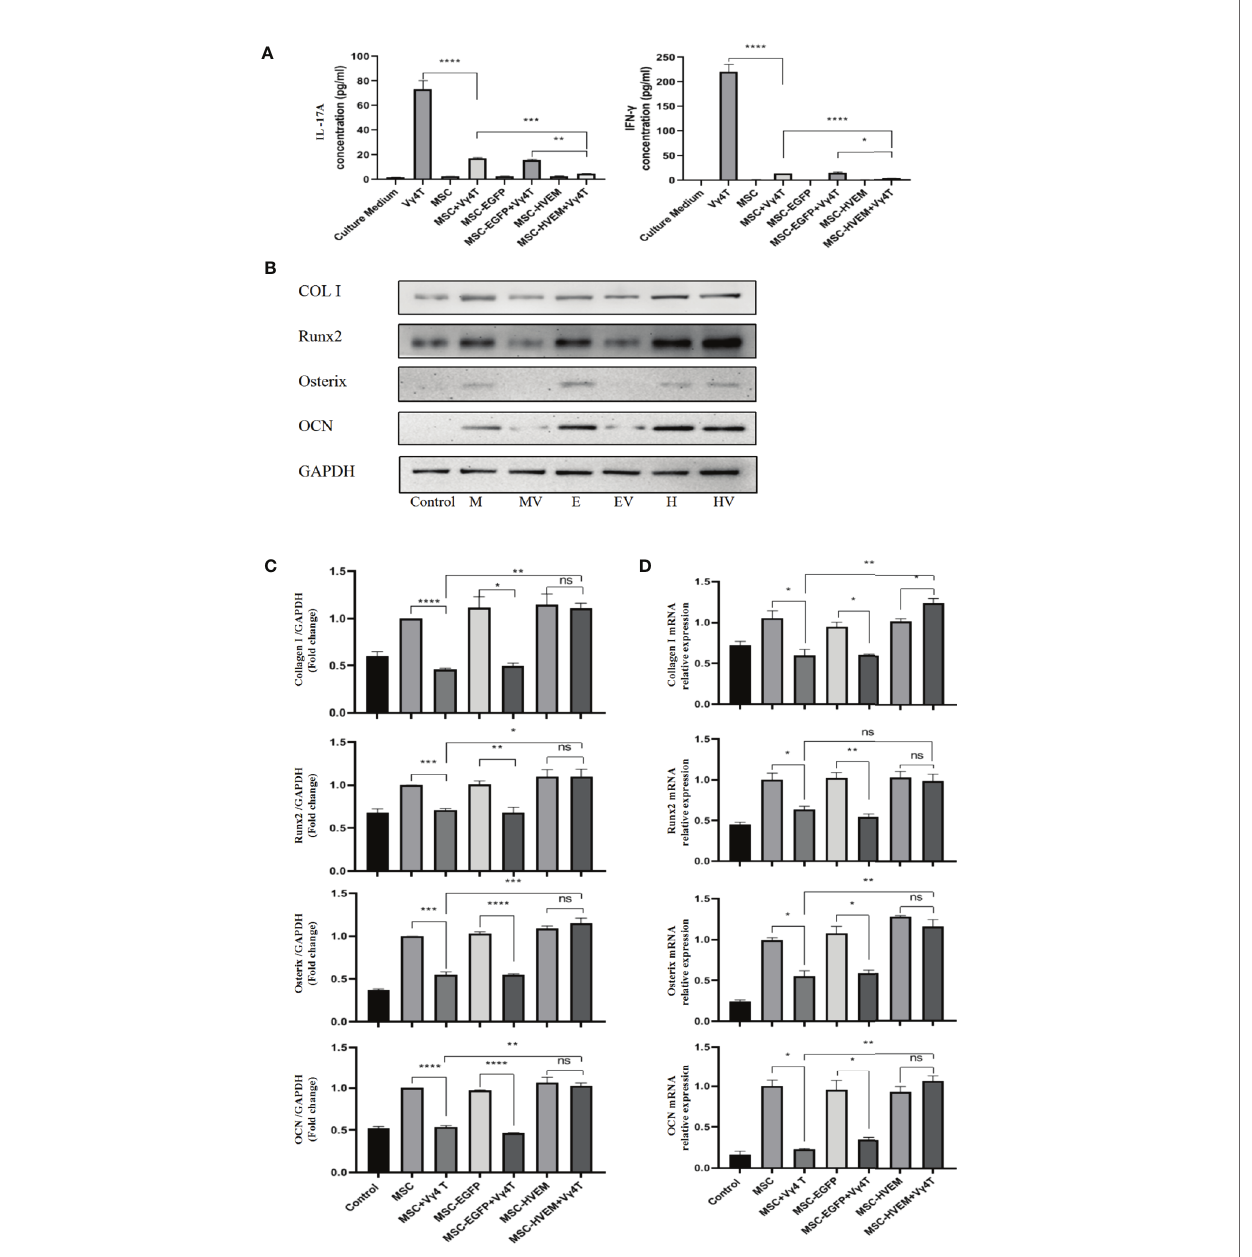
FIGURE 4 | V g 4T cells co-culture with MSCs or MSCs-HVEM then induced in osteogenic medium. (A) MSC can inhibit IL-17A and IFN- g secretion from puri fi ed V g 4T cells cells, the inhibition ability of MSCs-HVEM was stronger than that of MSC cells. (B, C) The Expression of markers of osteogenesis such as COL I, Runx2, Osterix, and OCN by MSCs or MSCs-HVEM with or not with V g 4T cells(the ratio is 1:4) were measured by Western blotting analyses, the osteogenic differentiation ability of MSC decreased when co-culture with V g 4T cells but MSCs-HVEM can counter or even reverse that trend .MSCs (M),MSCs + V g 4T cells (MV), MSCs-EGFP (E), MSCs-EGFP + V g 4T cells (EV), MSCs-HVEM (H), MSCs-HVEM + V g 4T cells (HV). (D) mRNA expression levelsof COL I, Runx2, Osterix, and OCN were tested by RT-PCR after 9 days of MSCs or MSCs-HVEM with or not with V g 4T cells (the ratio is 1:4, relative to expression in MSCs showed the same trend. Error bars represent mean ± SD. One-way ANOVA test was used to calculated P value (*P < 0.05, **P < 0.01, ***P < 0.001, ****P < 0.0001, ns P >